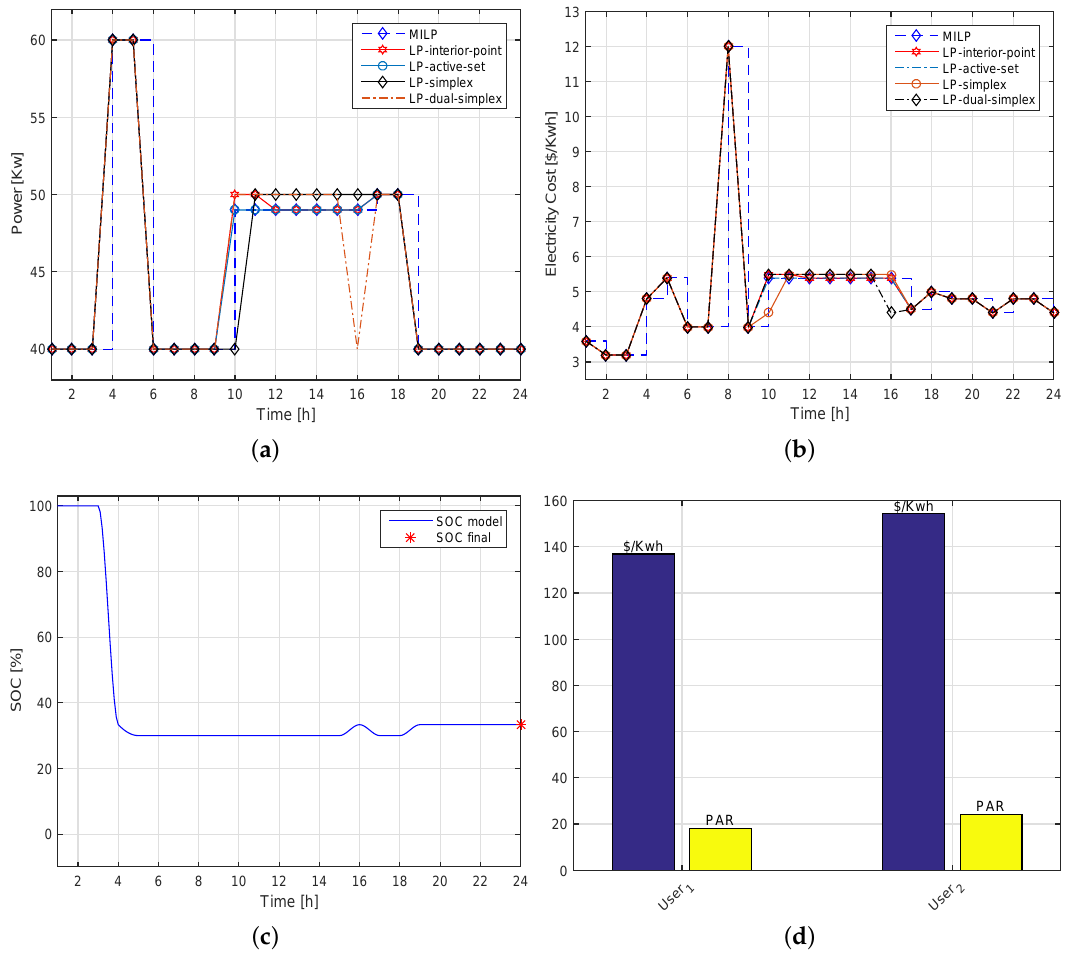
Figure 10. Comparison with power demand output by MILP solver for a single home on a day ( a ) Power analysis with different solvers ( b ) Cost analysis ( c ) State of charge output by LBPP ( d ) Overall Cost and PAR